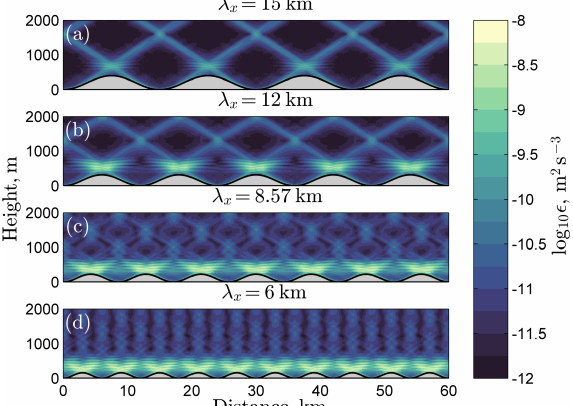
Figure 3. Same as in Figure 2, but for simulations where γ = 0.68, f = 7 × 10 − 5 s − 1 , and four values of λ x : (a) λ x = 15 km, (b) λ x = 12 km, (c) λ x = 8.57 km, (d) λ x = 6 km. The x -axis shows distance (km), and the z -axis shows height above the sea-floor